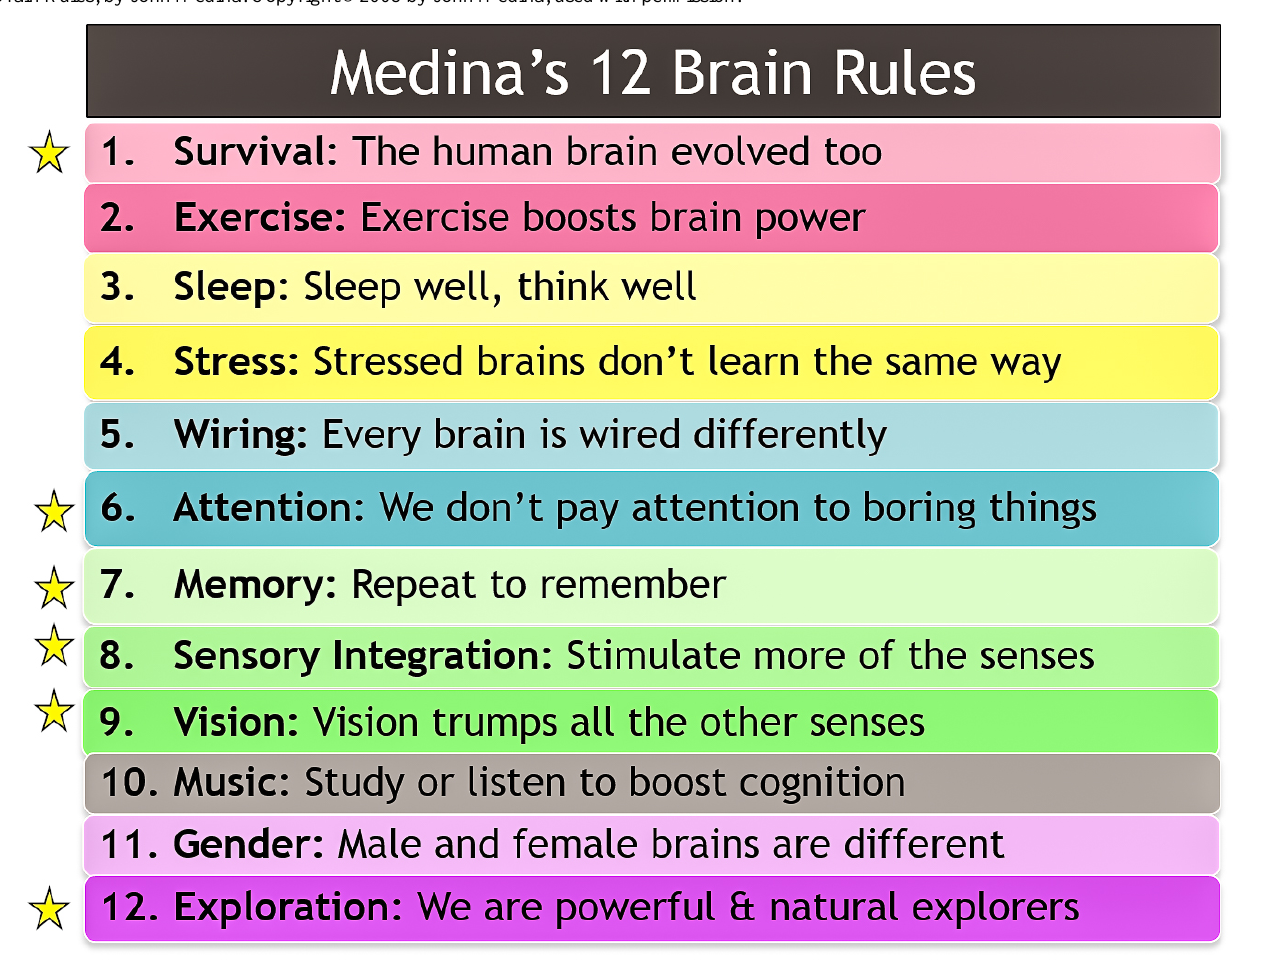
Figure 4. Six of Medina’s 12 Brain Rules that relate well to the potential of mental health mobile apps to enhance learning and personal growth. From Brain Rules, by John Medina. Copyright ©2008 by John Medina, used with